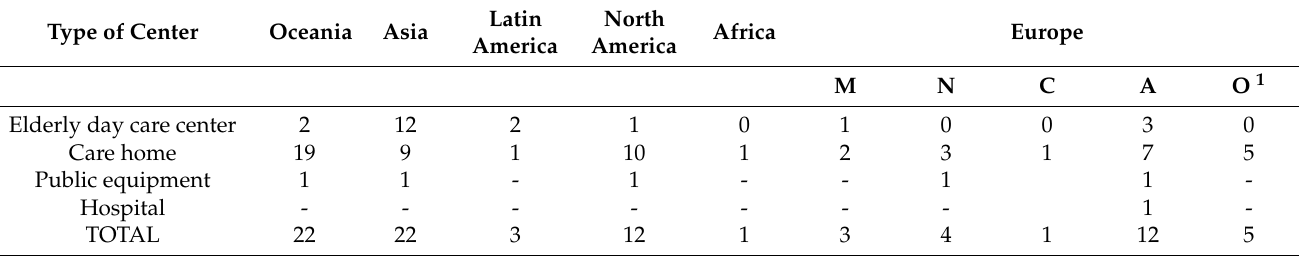
Table 1. Study cases included in the World Alzheimer Report 2020. Source: Own